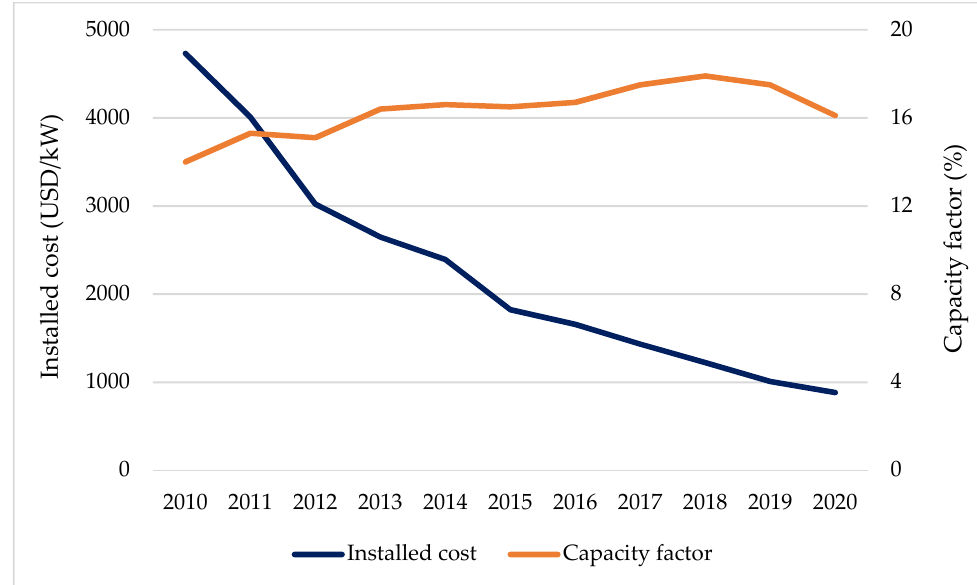
Figure 4. Global weighted-average installed costs and capacity factors of Solar PV in 2010–2020. Reprinted with permission from Refs. [9,10]. Copyright 2020/2021 International Renewable Energy Agency.